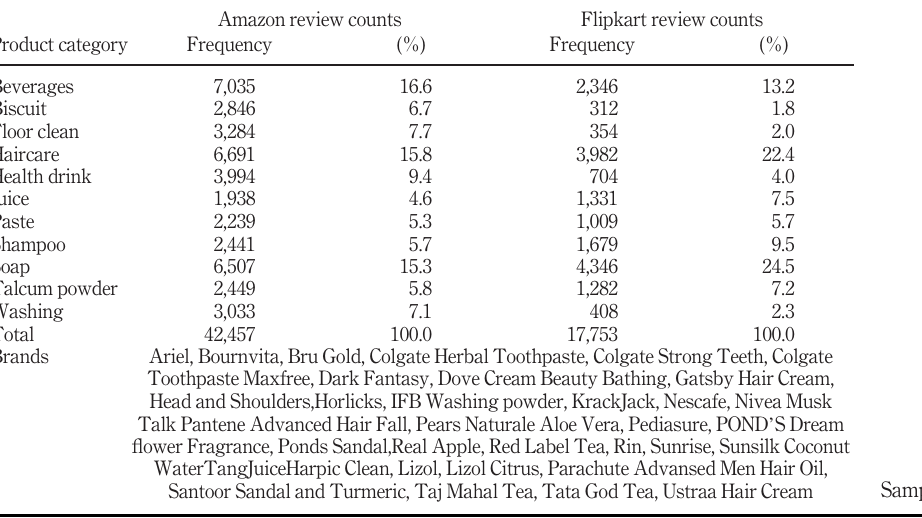
Table 1. Sample brands